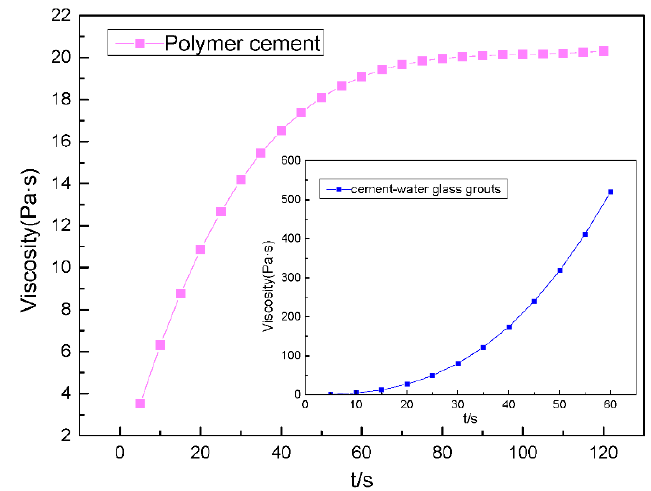
Figure 11. Variation of viscosity of typical polymer cement and cement–water glass grouts.